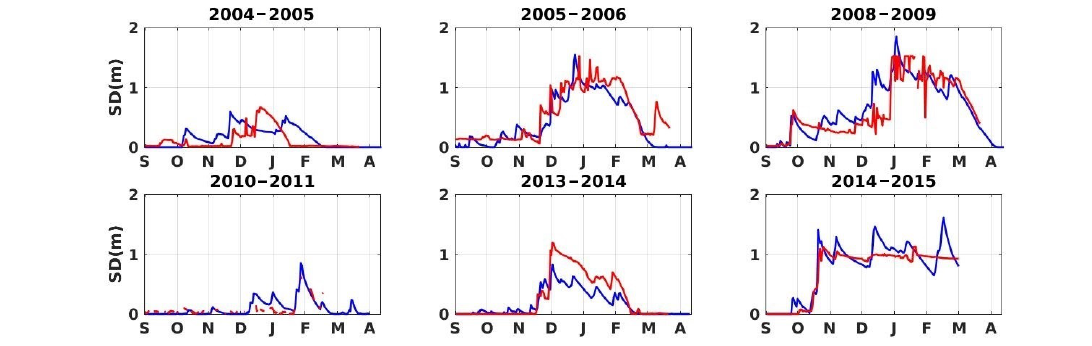
Figure 5. Time series of the simulated ( blue ) and observed ( red ) daily snow depth (SD) at